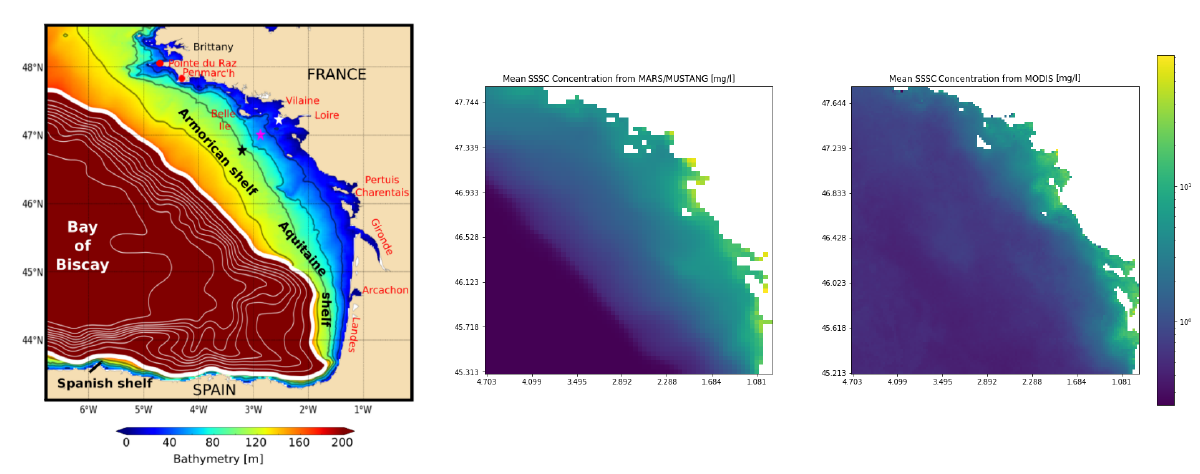
Figure 1. ( Left ) Bathymetry of the Bay of Biscay. Black lines represent isobaths 40, 70, 100, and 130 m. The thick white line (corresponding to the 180 m isobath) approximately delimits the shelf edge. Stars are validation points in [21] ( Middle ) Mean spatial distribution of SSSC (in mg/L) from the MARS-MUSTANG hydrosedimentary model. ( Right ) Mean spatial distribution of SSSC (in mg/L) from MODIS